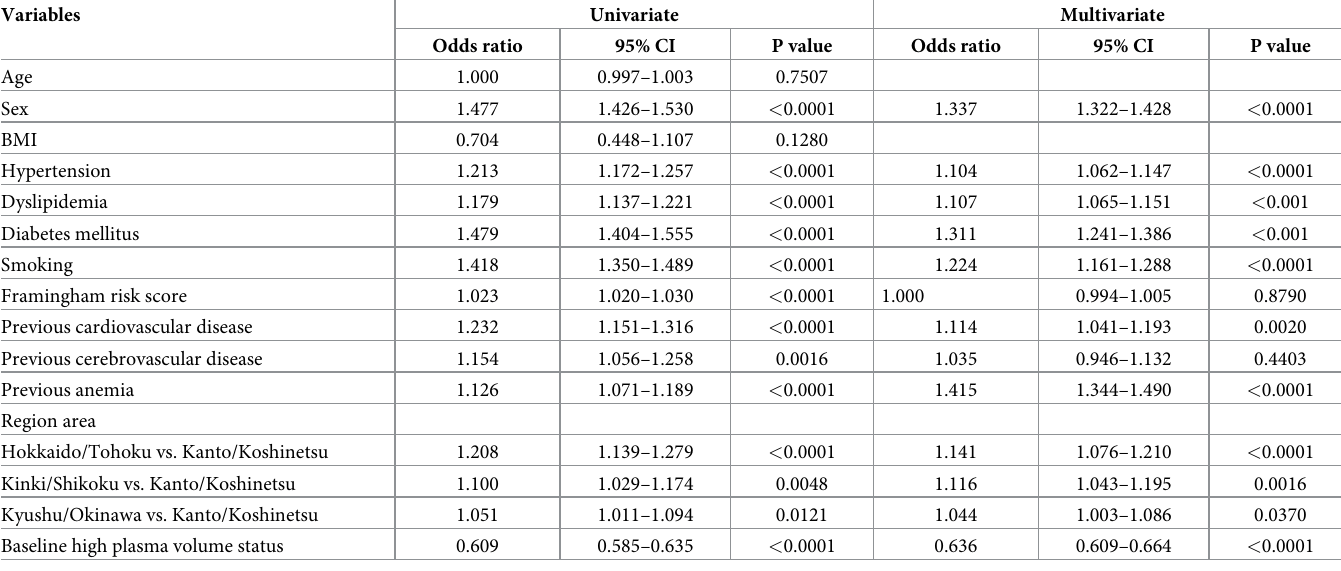
Table 3. Univariate and multivariate logistic analyses for abnormally 1-year large expansion in plasma volume. Variables Univariate Multivariate Odds ratio 95% CI P value Odds ratio 95%